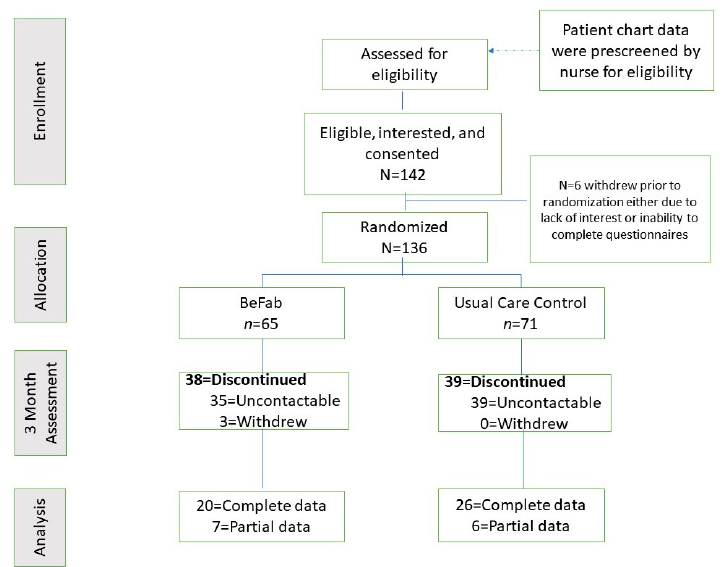
Figure 1. Enrollment flow diagram.